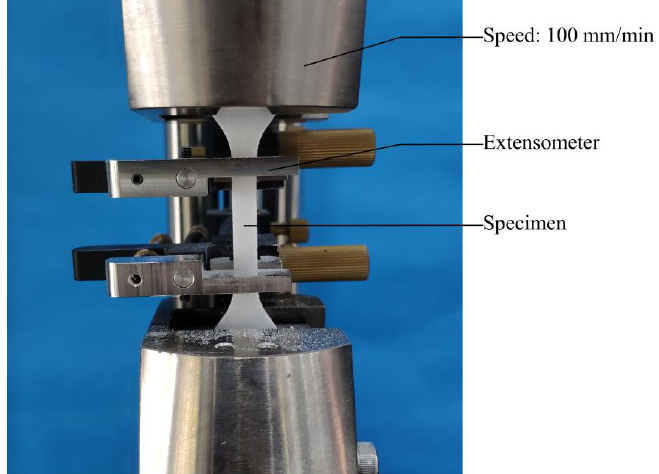
Figure 6. Tensile test setup.